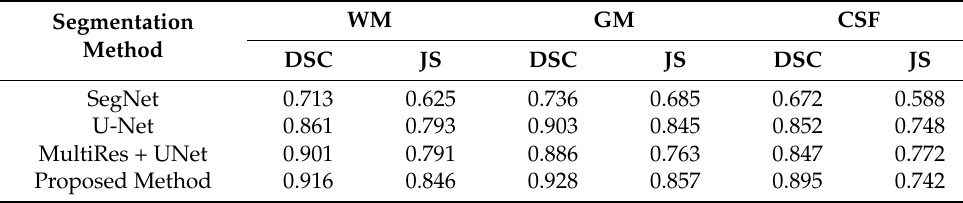
Table 2. Comparison of segmentation results of three segmentation algorithms.